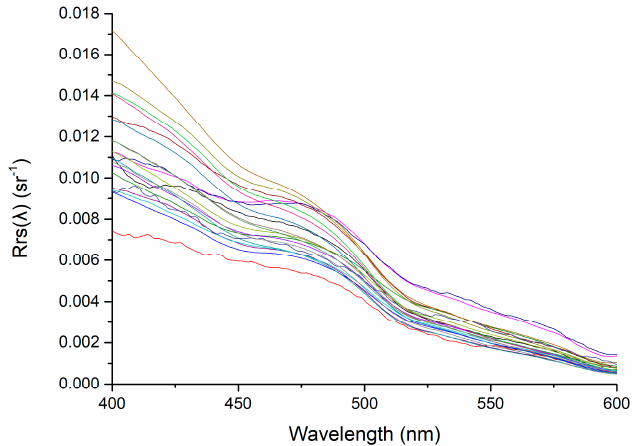
Figure 2. Measured R rs ( λ ) spectra at 21 stations in the Indian Ocean (IO) from a cruise in December 2016.